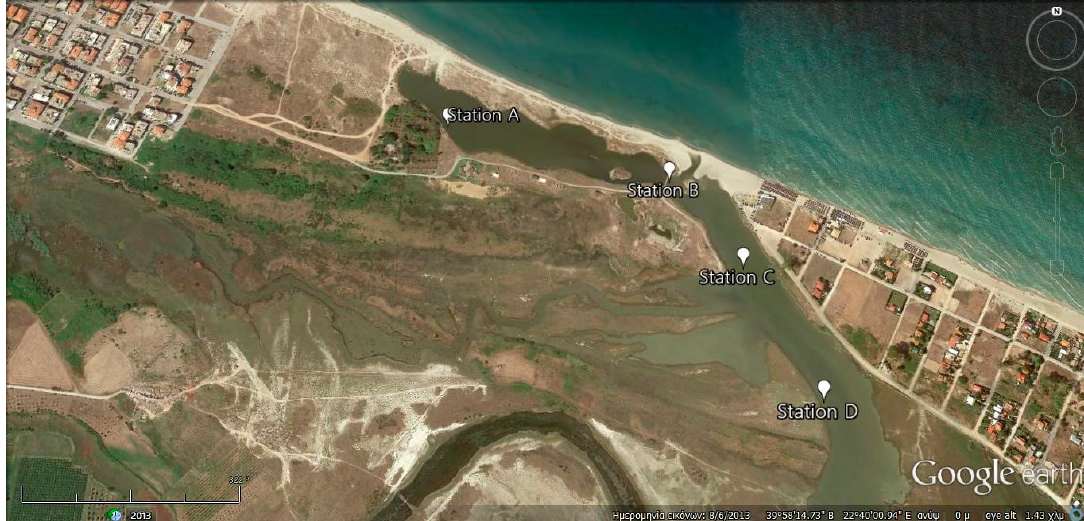
Figure 3. Papapouli Lagoon and sampling stations in the Thermaikos Gulf in the Northwest Aegean Sea. Source: Google Earth, modified.